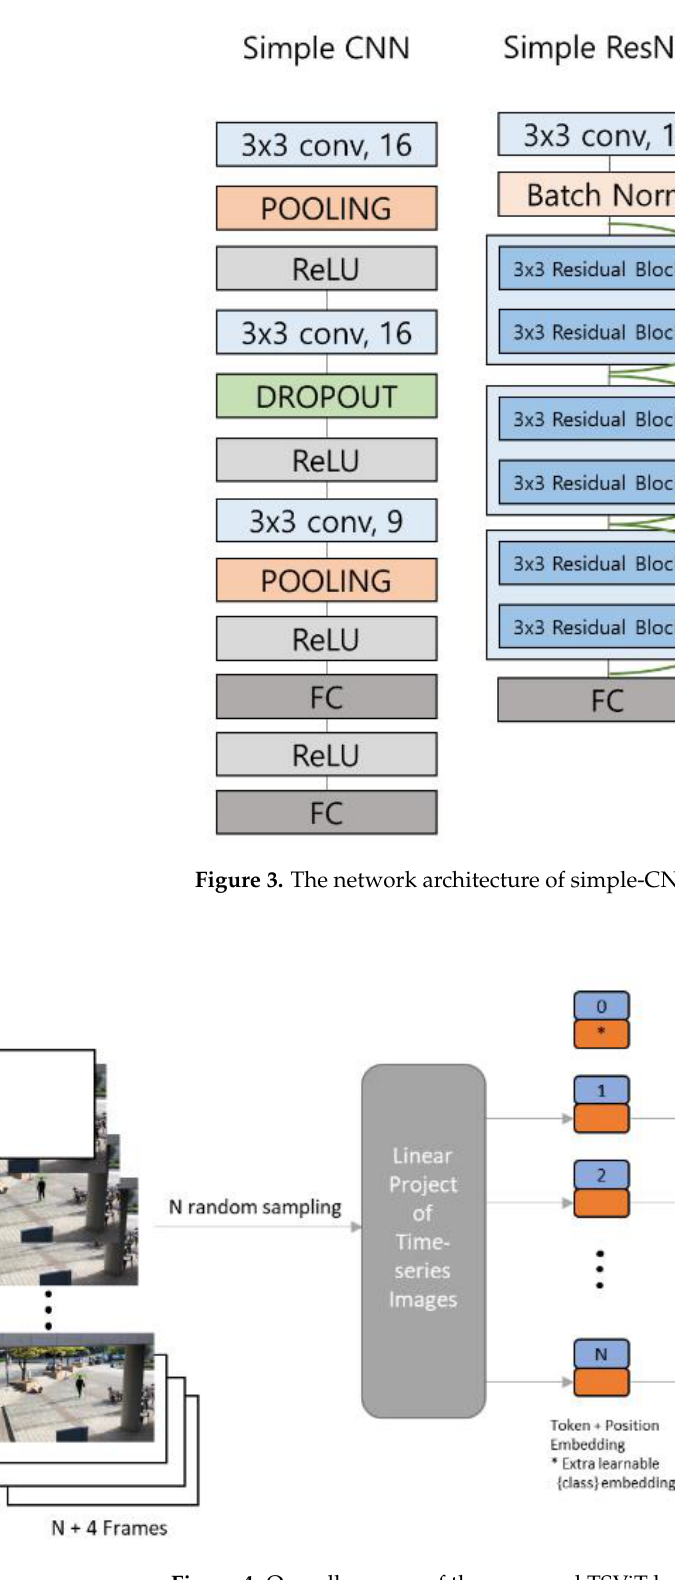
Figure 4. Overall process of the proposed TSViT-based tailing